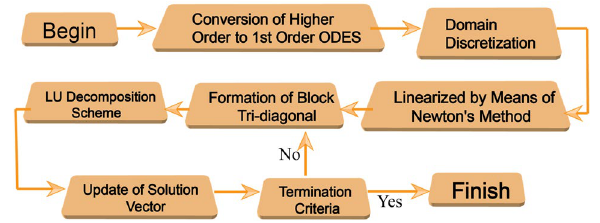
Figure 3. Current diagram demonstratingthe Keller box